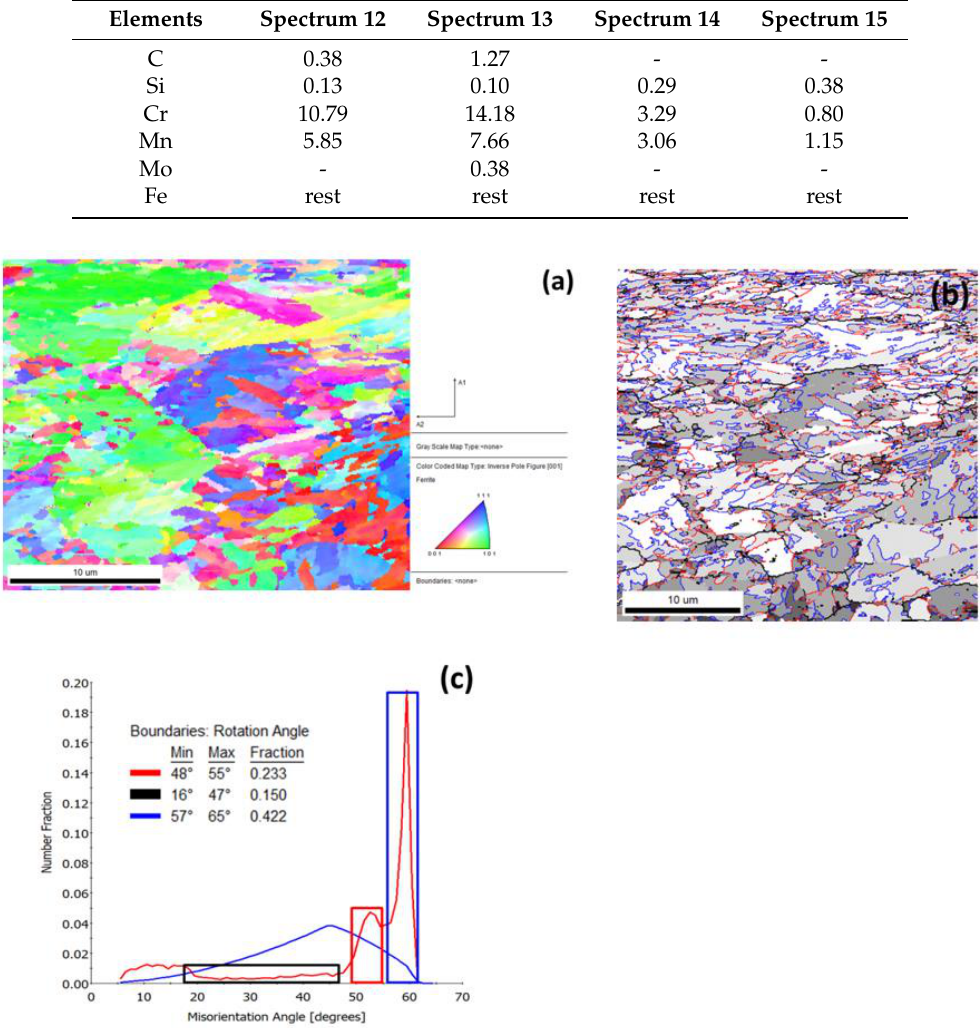
Figure 10. ( a ) Normal direction (ND) Inverse Pole Figure (IPF) map, ( b ) Grain Average Image Quality map presenting the different types of boundaries, ( c ) chart with number fraction distribution of the misorientation angles in the EBSD scan. The colors shown in legend are used to delineate the grain boundaries in Figure